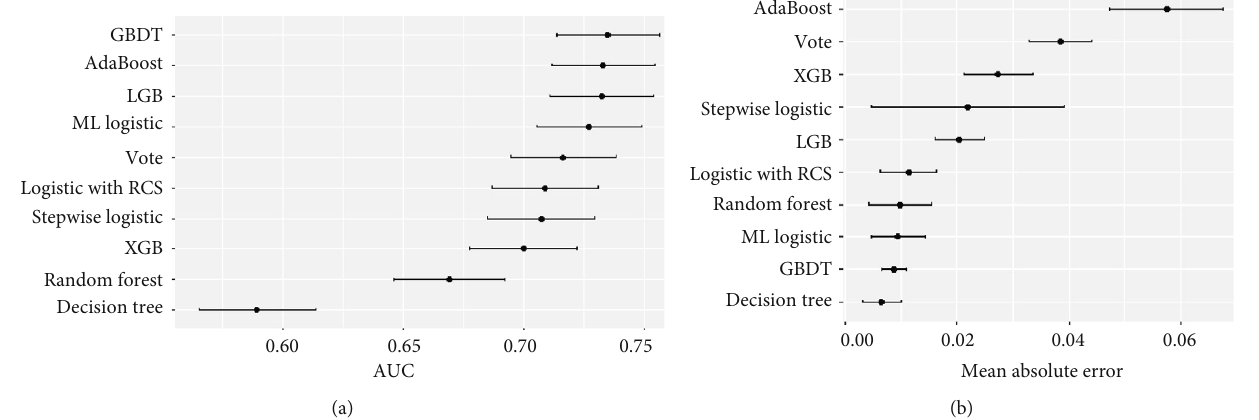
Figure 2: Results of discrimination and calibration metrics of machine learning and logistic regressions in the validation cohort. The AUC (a) and mean absolute error (b) are presented in each model as mean and 95% con fi dence intervals.